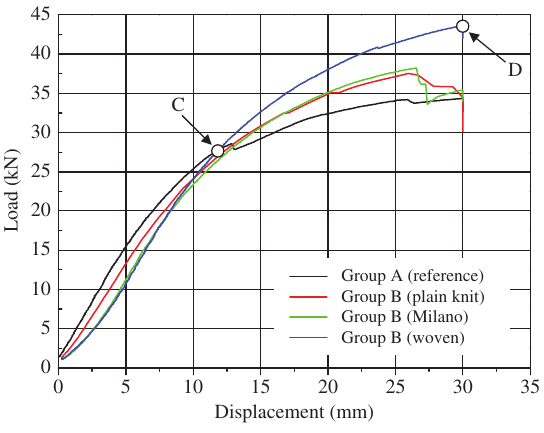
Figure 9 Photographs of failed Group B specimens. (A) I-shaped and (B) square hollow beams. Figure 7 Load-displacement curves of square hollow beams.